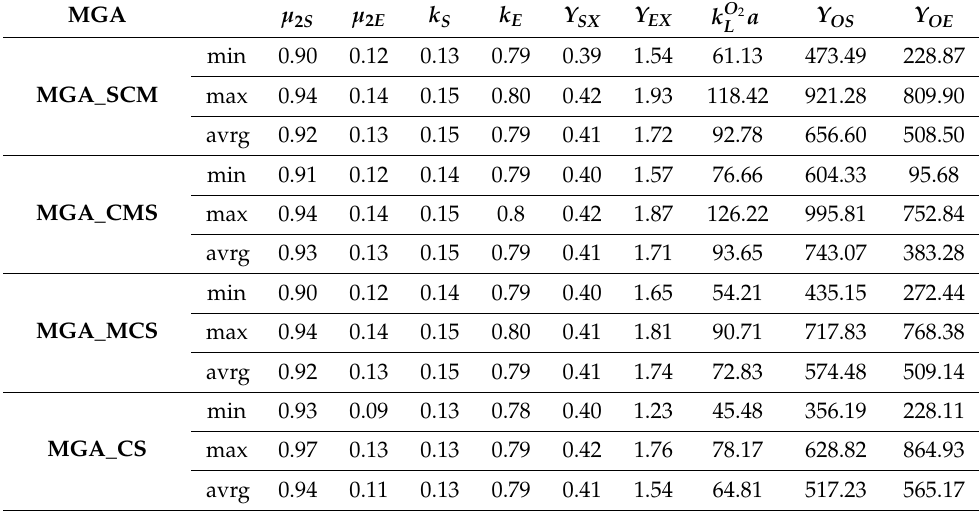
Table 2. Values of the model parameters for the top levels of investigated MGA.